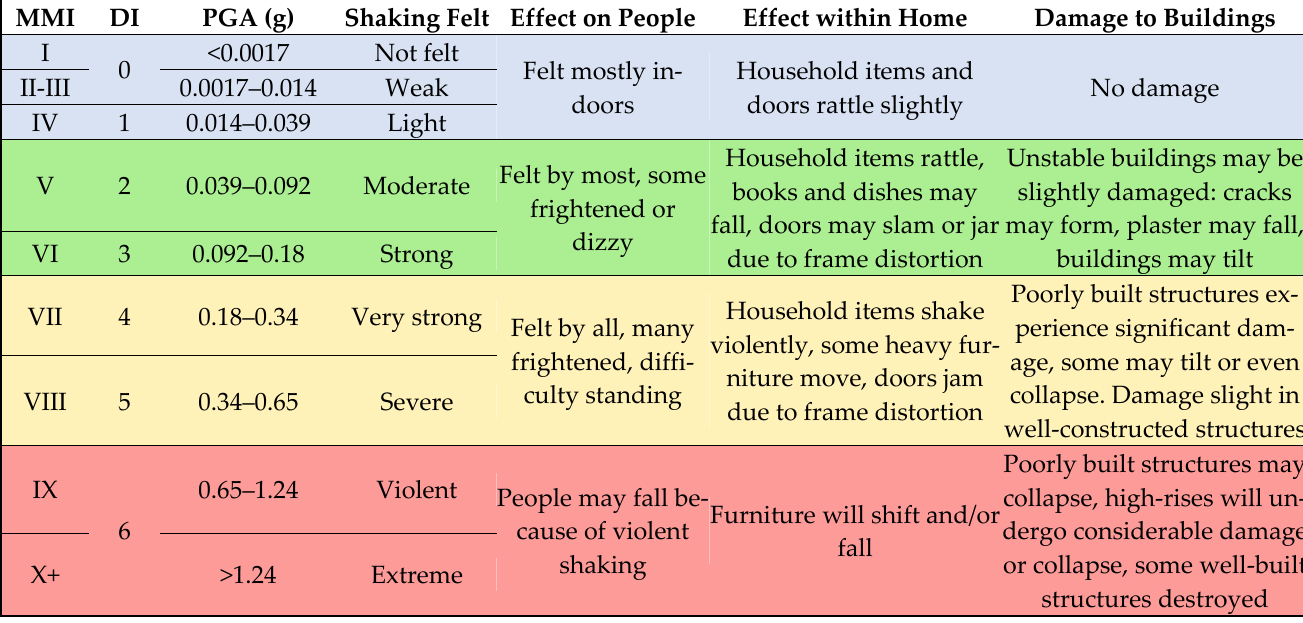
Table 1. Correlations between the twelve degrees of Modified Mercalli Intensity (MMI), six degrees of the proposed Damage Intensity (DI) scale and ground acceleration values [47,51]. Four major DI severity levels are proposed for our public self-evaluation tool: low (MMI = I–IV; blue), medium (MMI = V–VI; green), high (MMI = VII–VIII; yellow) and very high (MMI > IX; red).